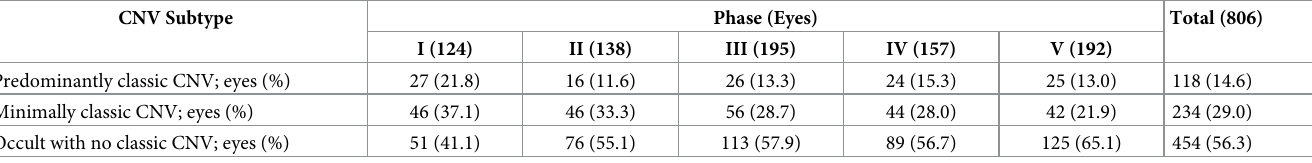
Table 3. Subtypes of CNV detected by fluorescein angiography in typical AMD. CNV